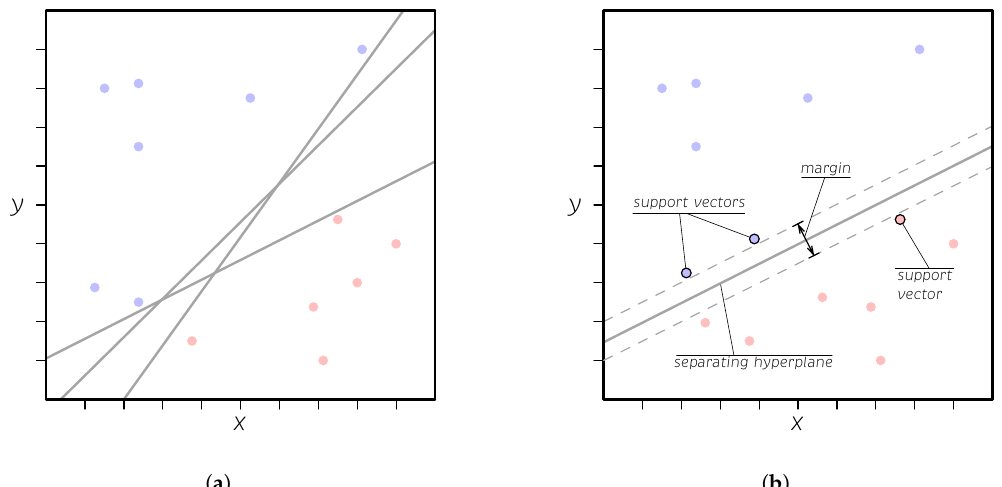
Figure 4. ( a ) There are two classes (blue and red), which are separated by three hyperplanes (in this case lines) out of many possible; ( b ) optimal hyperplane that maximizes the margin between